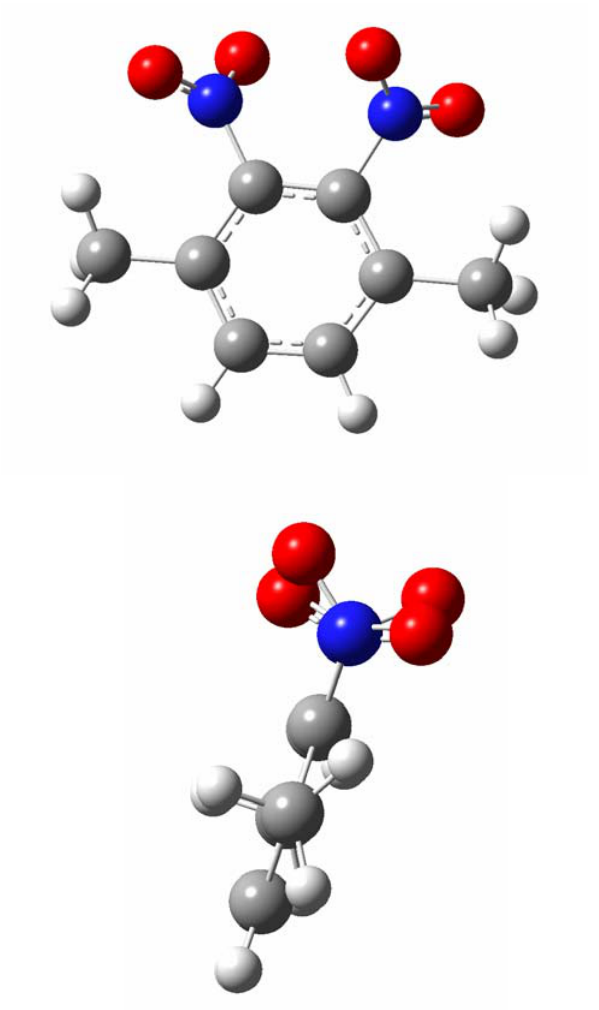
Figure 3. The face and side face views of